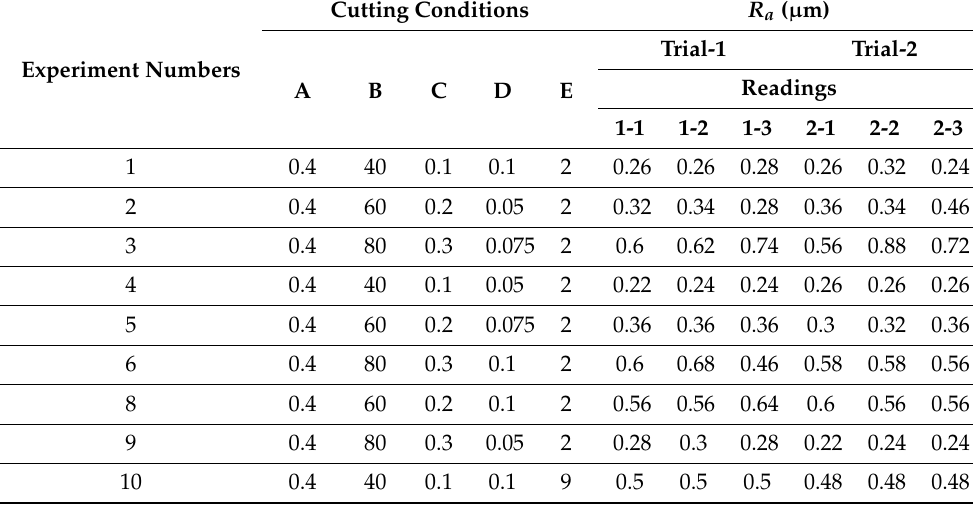
Table 6. Experimental results regarding surface roughness ( R a